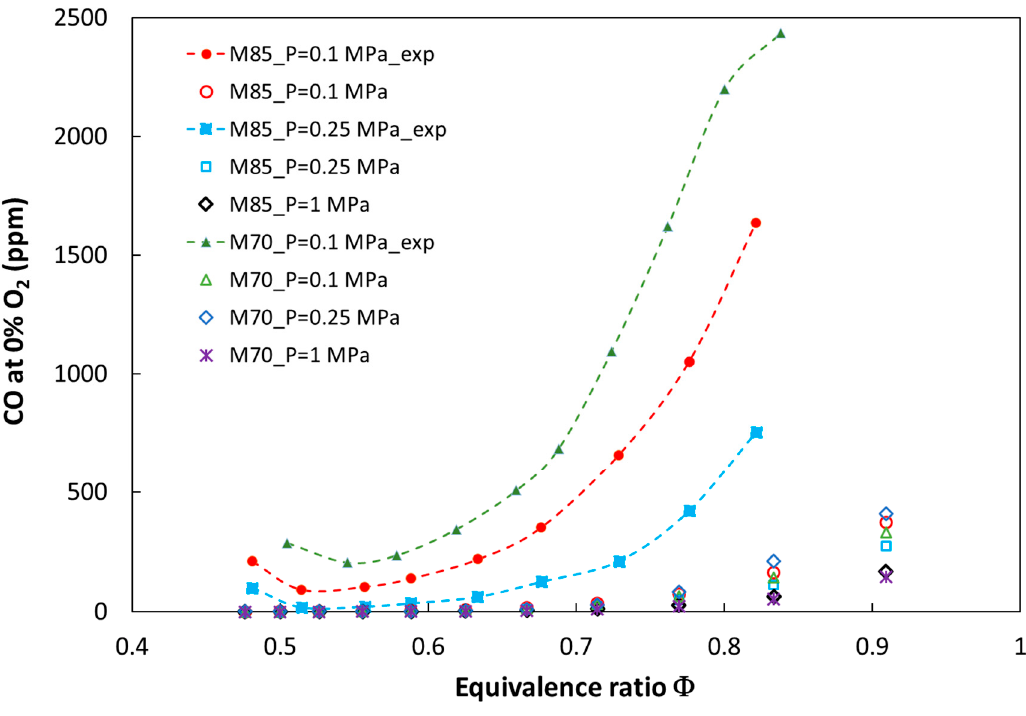
Figure 4. Calculated and experimental CO emissions for the tested fuels at elevated combustion pressures.